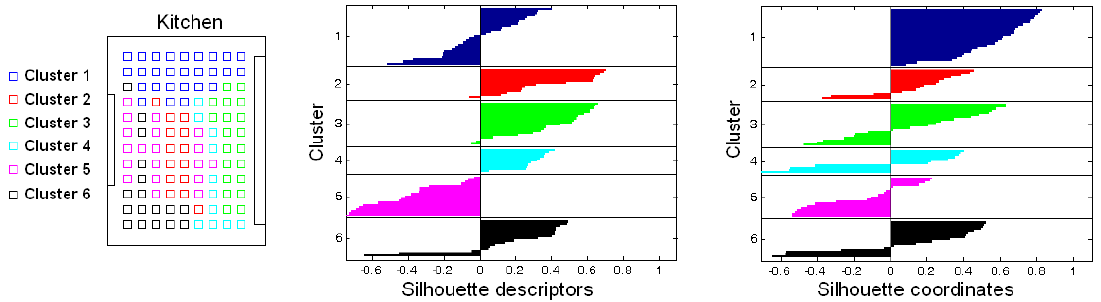
Figure 12. Results of a sample unsuccessful clustering process performed with the images of the kitchen room. Bird’s eye view of the capture points, showing with colors their belonging to the resulting clusters, silhouette calculated from the visual descriptors and silhouette calculated from the coordinates of the capture